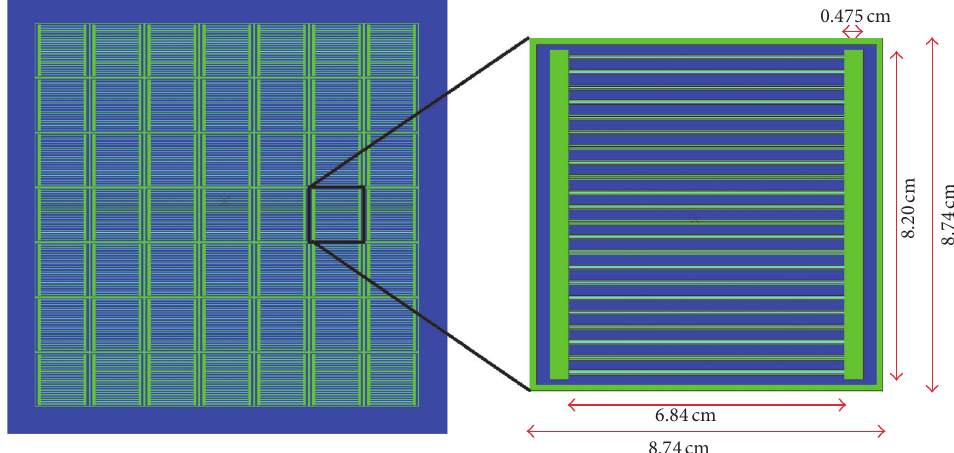
Figure 1: Geometric representation of the benchmark.